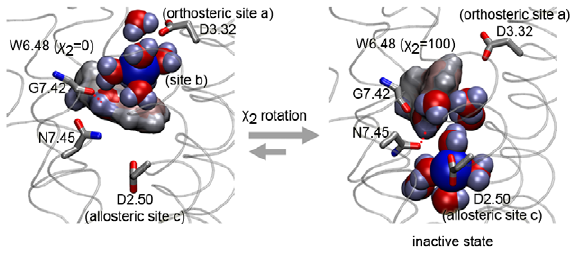
Figure 4. Mechanism of the sodium-induced effect on the rotamer switch (Trp 6.48). Sodium-induced effect is mediated by cation- P interaction of the hydrated positively charged sodium ion and the negative charges of the Trp6.48 ring. The sodium ion, water molecules as well as the Trp6.48 are colored according to their partial charges (blue: positive, red: negative). Transition of a sodium ion from Asp3.32 (site a / b , x 2 =0) to Asp2.50 (site c , x 2 =100) induces a conformational change of Trp6.48 due to electrostatic interactions between the hydrated positively charged sodium ion and the negative charges of the indole ring of